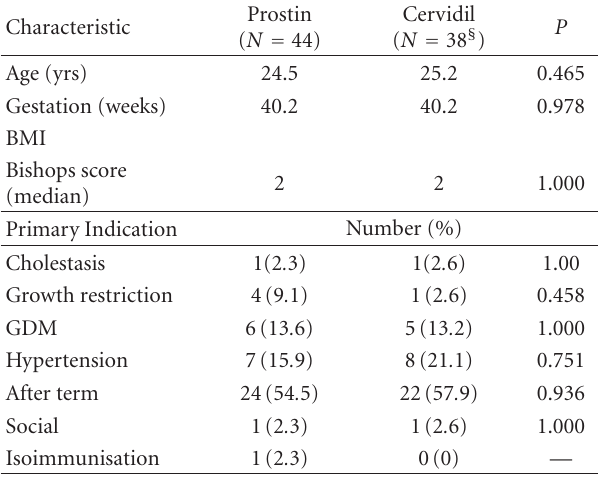
Table 1: Baseline characteristics of the women in the Prostin and Cervidil induction agent